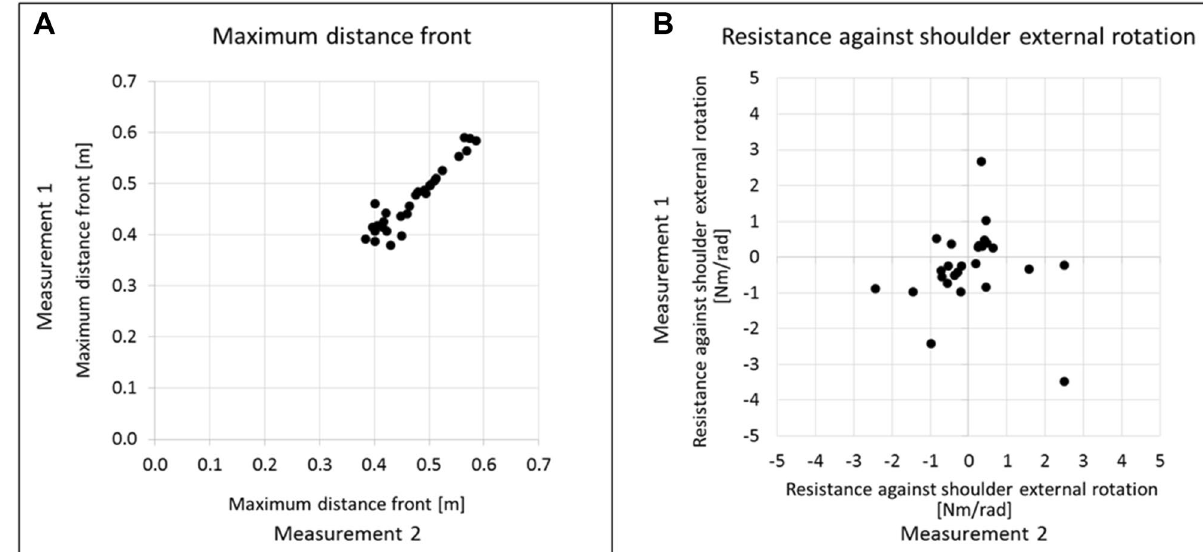
Figure 3. Data distribution of the parameters with the highest and the lowest intraclass correlation coefficients (ICC). ( A ) The parameter ‘maximum distance to front’ of the Workspace assessment which showed the highest ICC (= 0.95). ( B ) The parameter ‘resistance against shoulder external rotation’ of the Resistance to Passive Movement assessment (RPM) which showed the lowest ICC (= −